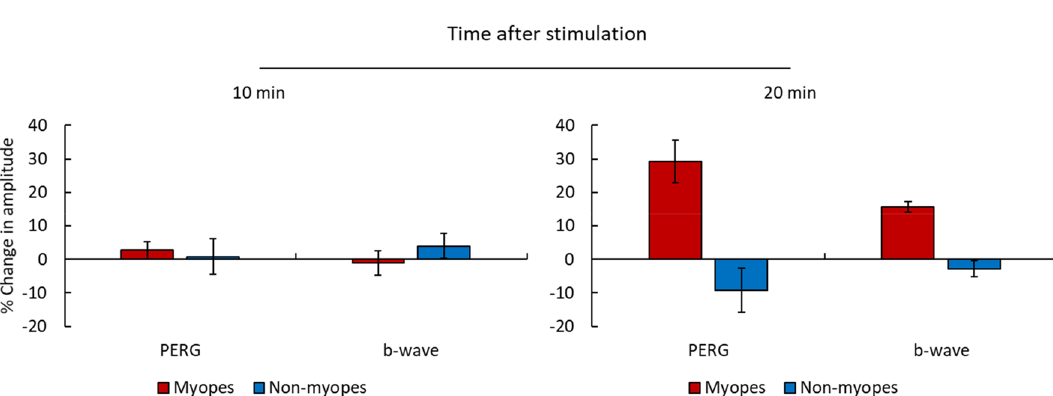
Figure 5. Mean and standard error of the mean (SEM) of change in ERG amplitude relative to baseline in 5 myopes and 5 non-myopes for b-wave and PERG P50-N95 at 10 min (left) and 20 min (right) after